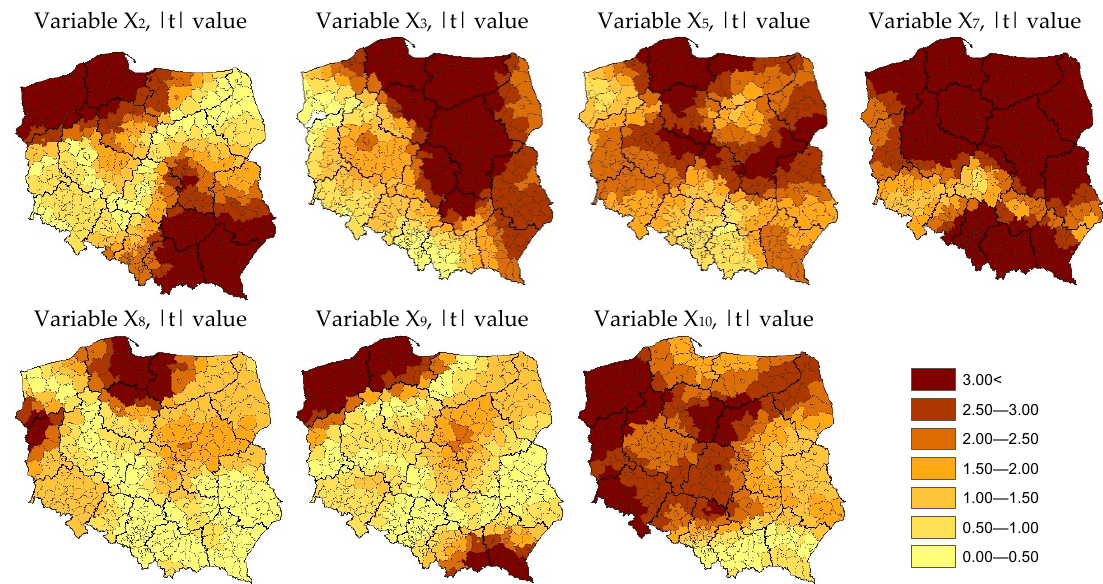
Figure 4. Spatial distribution of statistic t for coefficients at local variables in the MGWR1 model. Source: own research.